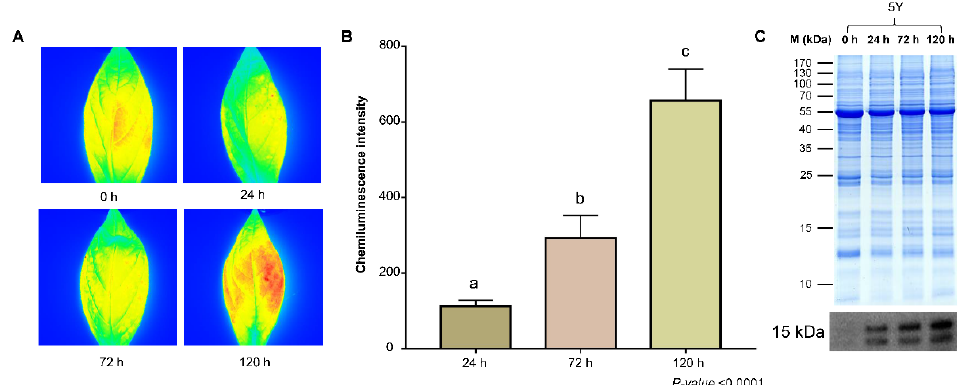
Figure 1. Analysis of salt-stress-induced changes in ginseng. ( A ) Chlorophyll fluorescence measure- ment at different timepoints following salt-stress treatment in ginseng leaves. ( B ) H 2 O 2 measurement in the harvested culture fluid at different timepoints of salt-stress treatment. ( C ) SDS-PAGE showing changes in ginseng proteins in response to salt stress and the Western blot of salt-marker superoxide dismutase. Different letters of each sample indicated statistically significant ( p-value < 0.0001 ) .